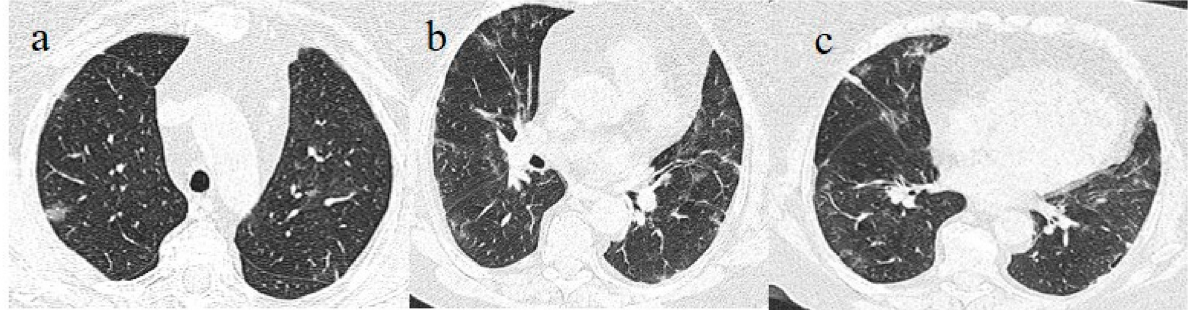
Figure 9. Chest CT performed on 21 July showing some central and peripheral GGO with interstitial thickness and multifocal distribution in the superior lobes ( a ), in the middle and inferior lobes ( b ) and in the inferior lobes ( c